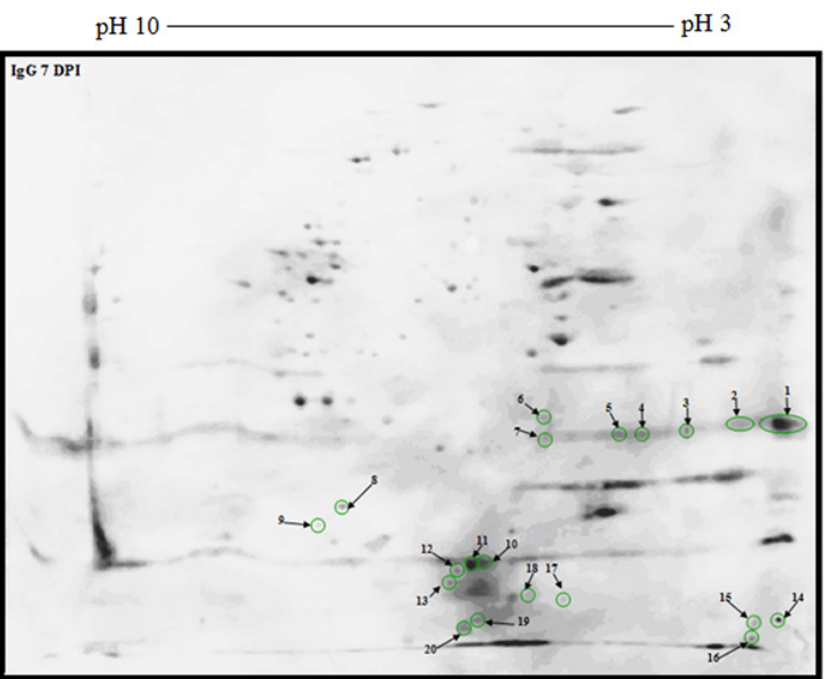
Fig 6. Immunoblot picture of unique reactive polypeptide spots of 2-DE separated T . gondii strain RH tachyzoite proteins using antibodies specific for IgG 7